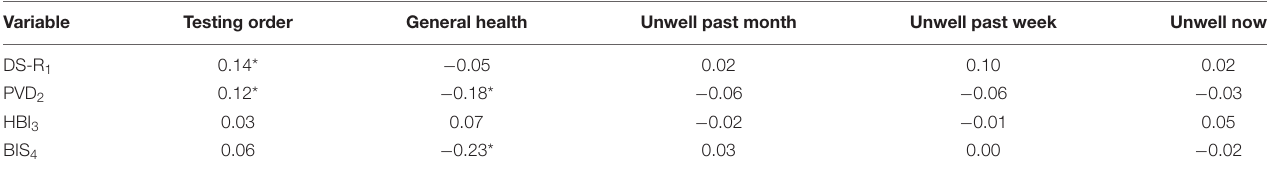
TABLE 3 | Correlation (Spearman) between testing order, general health, and recent illness, and the total scores for the main measures, partialling out age and gender, for the current dataset.